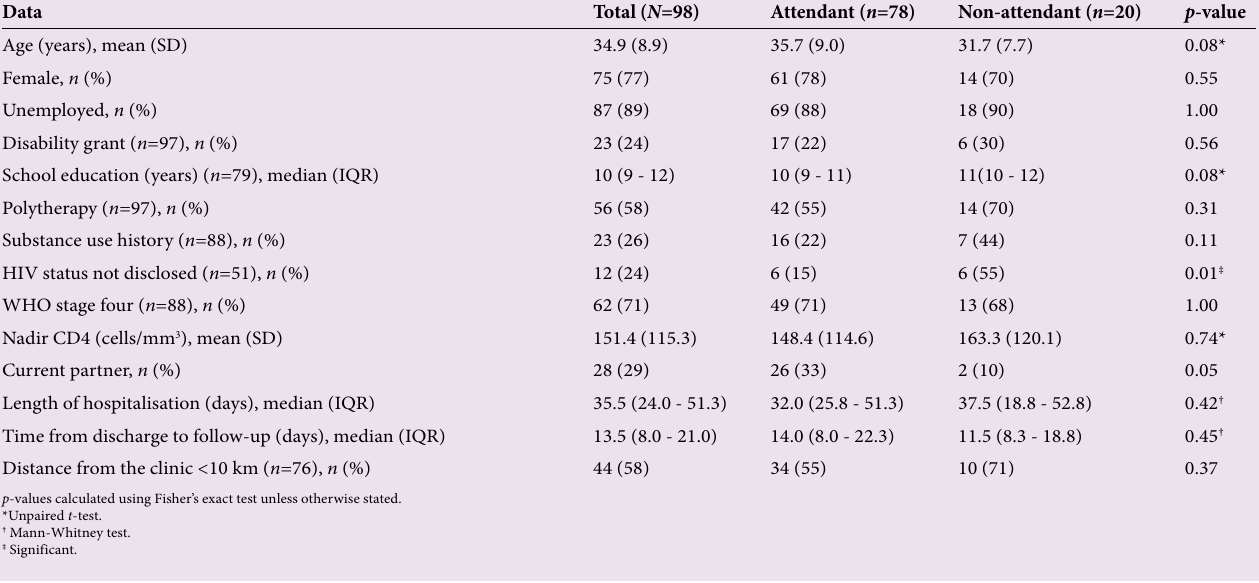
Table 1. Comparison of demographic and clinical data of attendant v. non-attendant groups Data